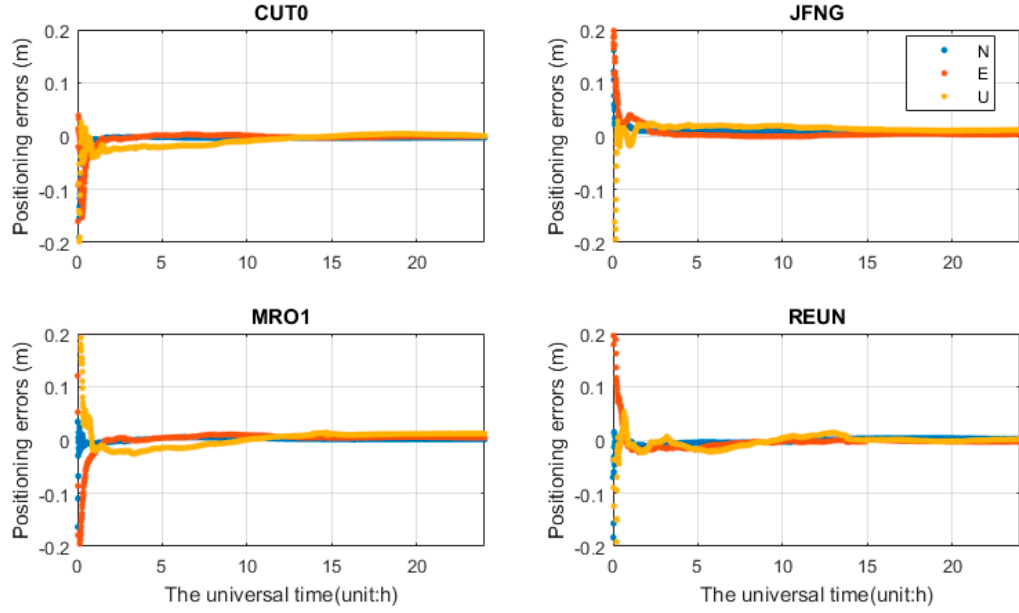
Figure 7. Positioning error (N, E, and U) of b1b2 quad-constellation PPP. For each plot, the horizontal axis represents the universal time (unit: h), and the vertical axis represents the corresponding positioning error (unit: m).